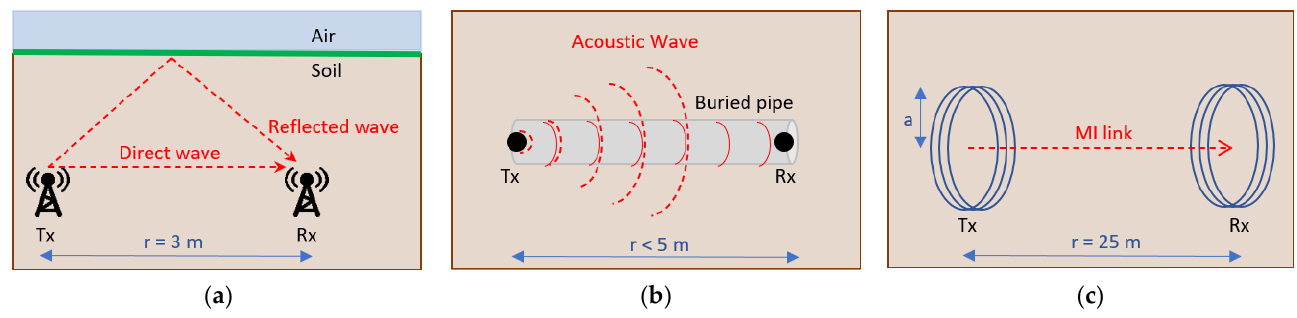
Figure 1. Simple wireless underground communication systems based on ( a ) electromagnetic waves, ( b ) acoustic waves and ( c ) magnetic induction (MI).